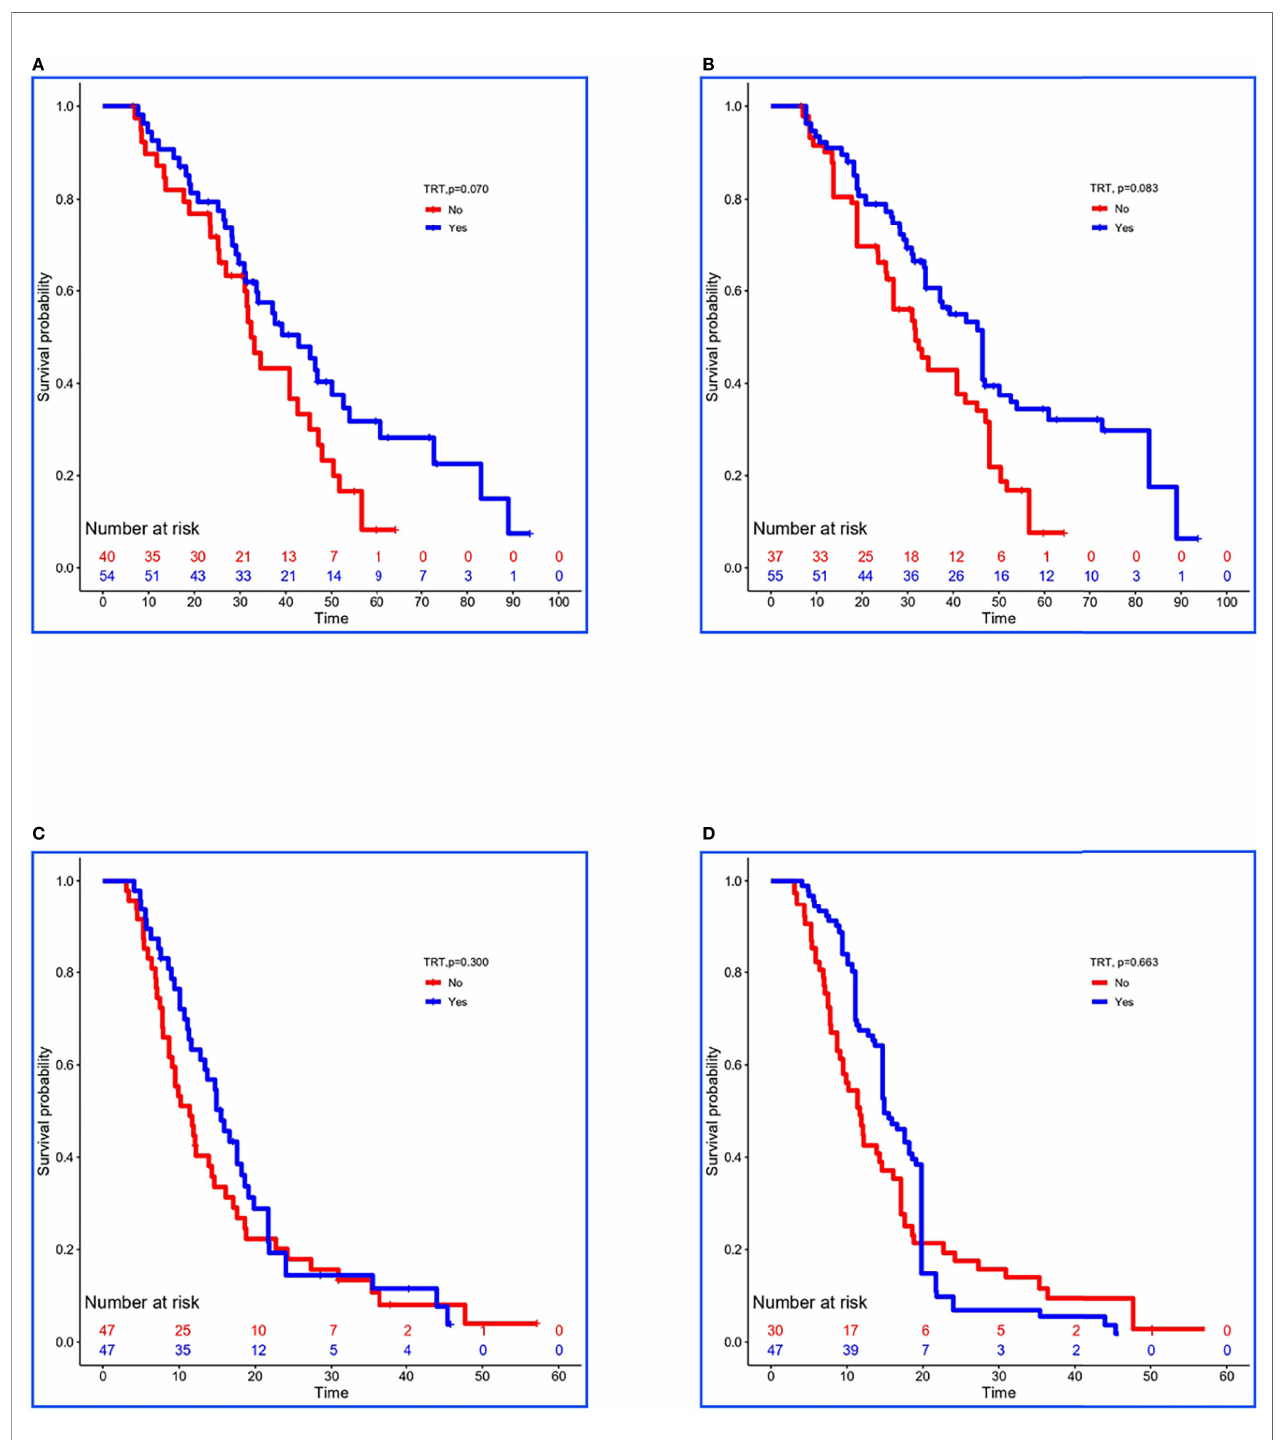
FIGURE 2 | Kaplan – Meier survival analyses for patients between groups. (A, B) Survival curves for low-risk patients between non-TRT and TRT groups when clinical characteristics were unmatched and matched using stabilized IPTW analysis in the training set. (C, D) Survival curves for high-risk patients between non-TRT and TRT groups when clinical characteristics were unmatched and matched using stabilized IPTW analysis in the training set.